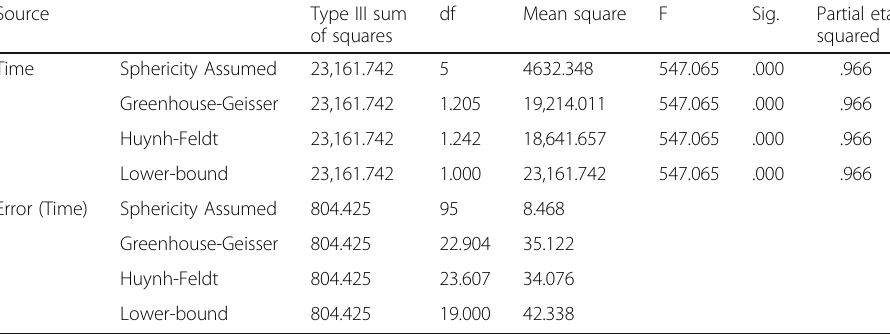
Table 2 Tests of within-subjects effects